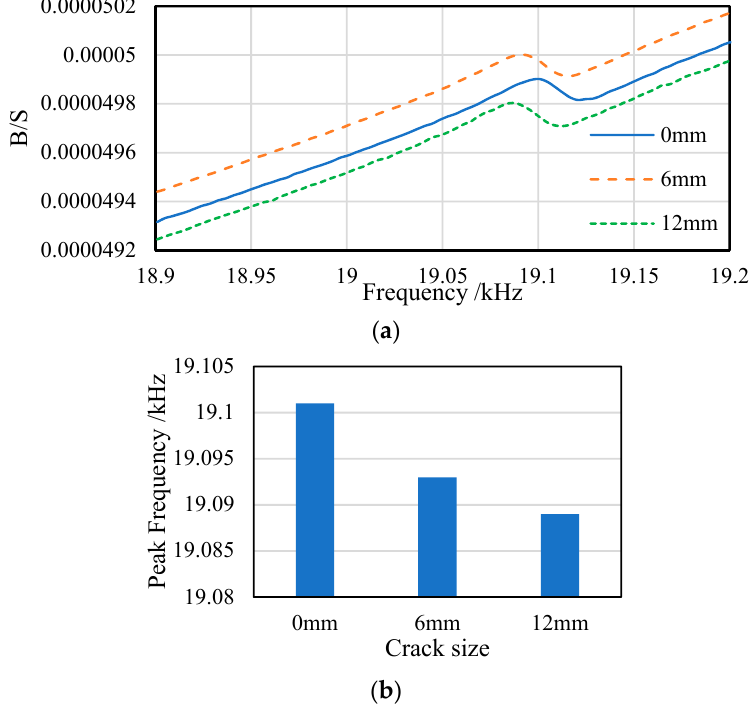
Figure 9. Experimental results ( a ) piezoelectric admittance spectrum and ( b ) peak frequency tendencies in 18.9 kHz–19.2 kHz with different crack sizes.